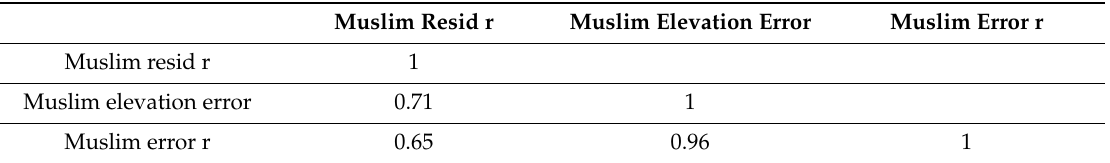
Table 1. Correlations among bias metrics. n = 484. Note that these analyses are based on data from Kirkegaard & Bjerrekær [6].